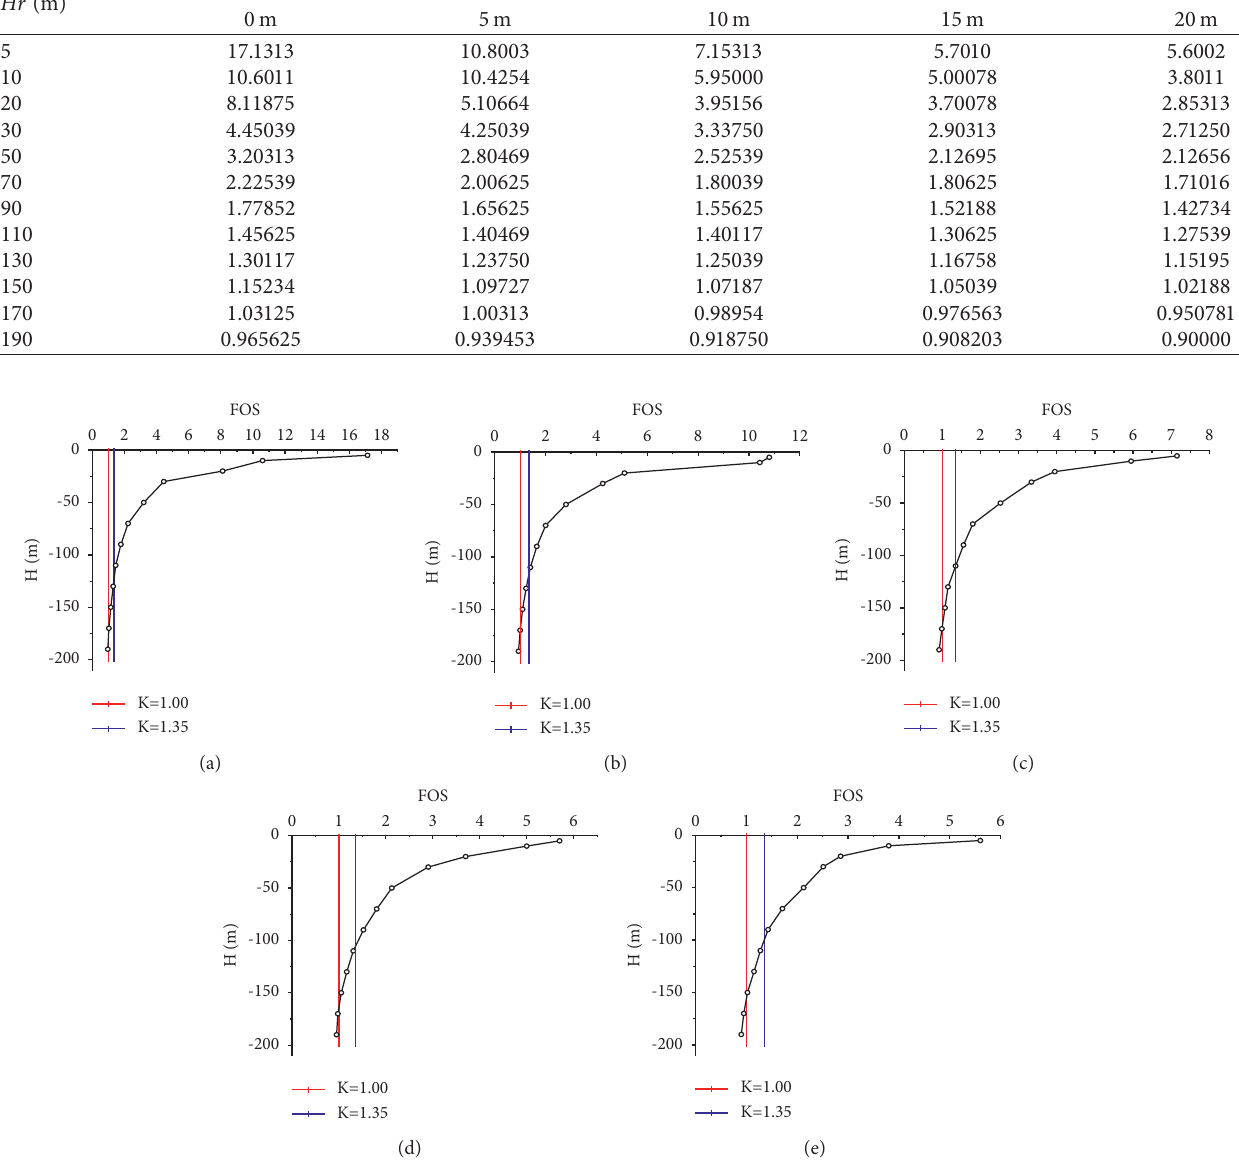
Figure 8: Variation curve of the foundation pit vertical rock wall FOS with Hs . (a) Hs � 0m. (b) Hs � 5m. (c) Hs � 10m. (d) Hs � 15m. (e) Hs � 20